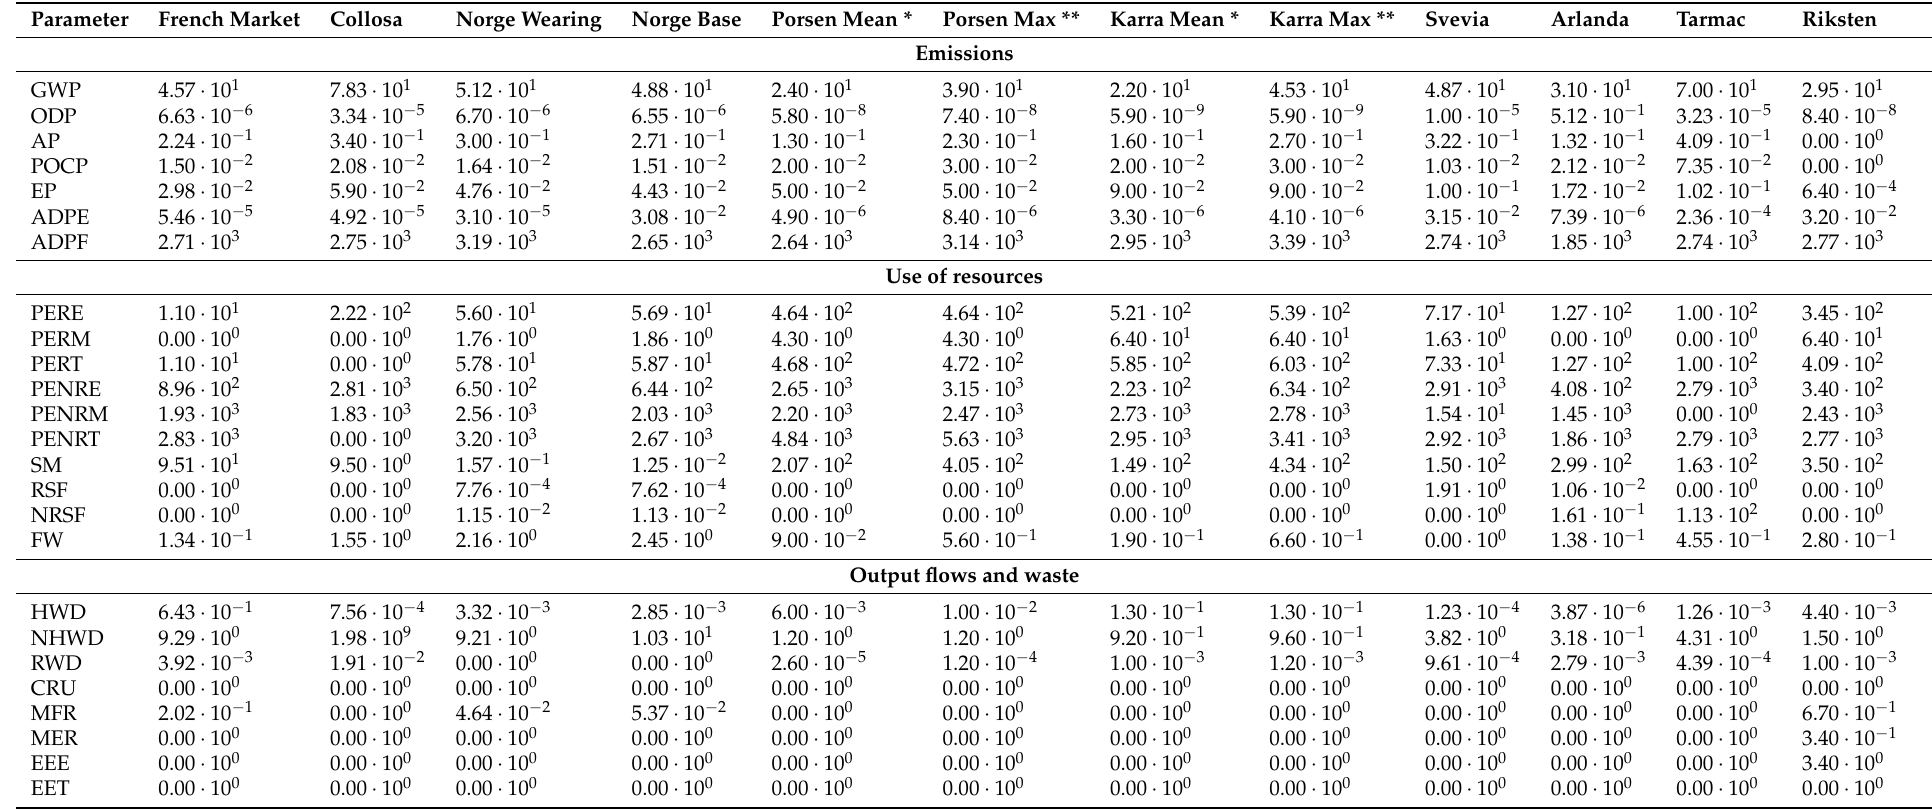
Table 6. Data retrieved by the European EPD certifications. All values are referred to 1 ton of asphalt mixture